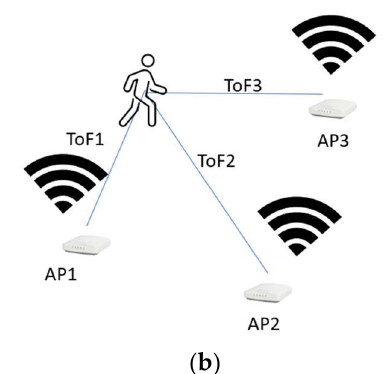
Figure 12. WiFi sensing may be used for many different applications: Localization, intrusion detec- tion, health and medical monitoring, range detection and estimation, gesture recognition, gain recognition, and fall detection.